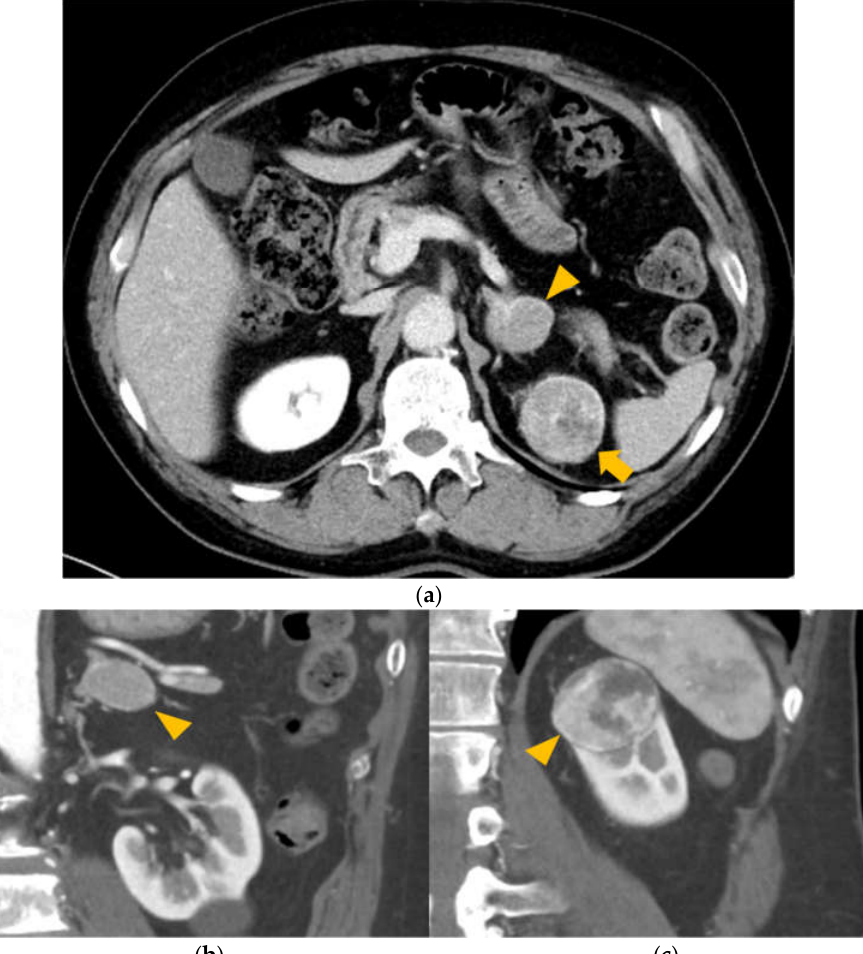
Figure 1. Position of metastatic and primary cancers. ( a ) Primary tumor in the left kidney (arrow) and metastatic tumor in the left adrenal gland (arrowhead). ( b ) Metastatic tumor in the left adrenal gland (arrowhead). ( c ) Renal cell carcinoma in the upper pole of the left kidney (arrowhead).